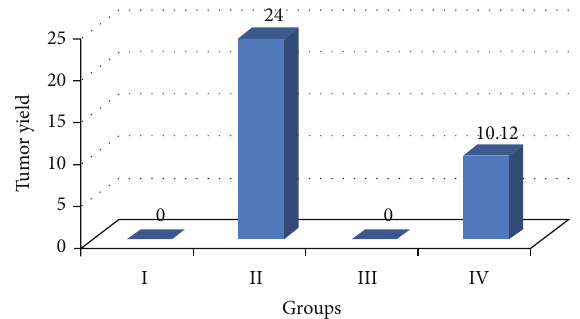
Figure 3: Variations in tumor yield after DENA/CCl 4 induced hepatic carcinogenesis with/without ACE administration.